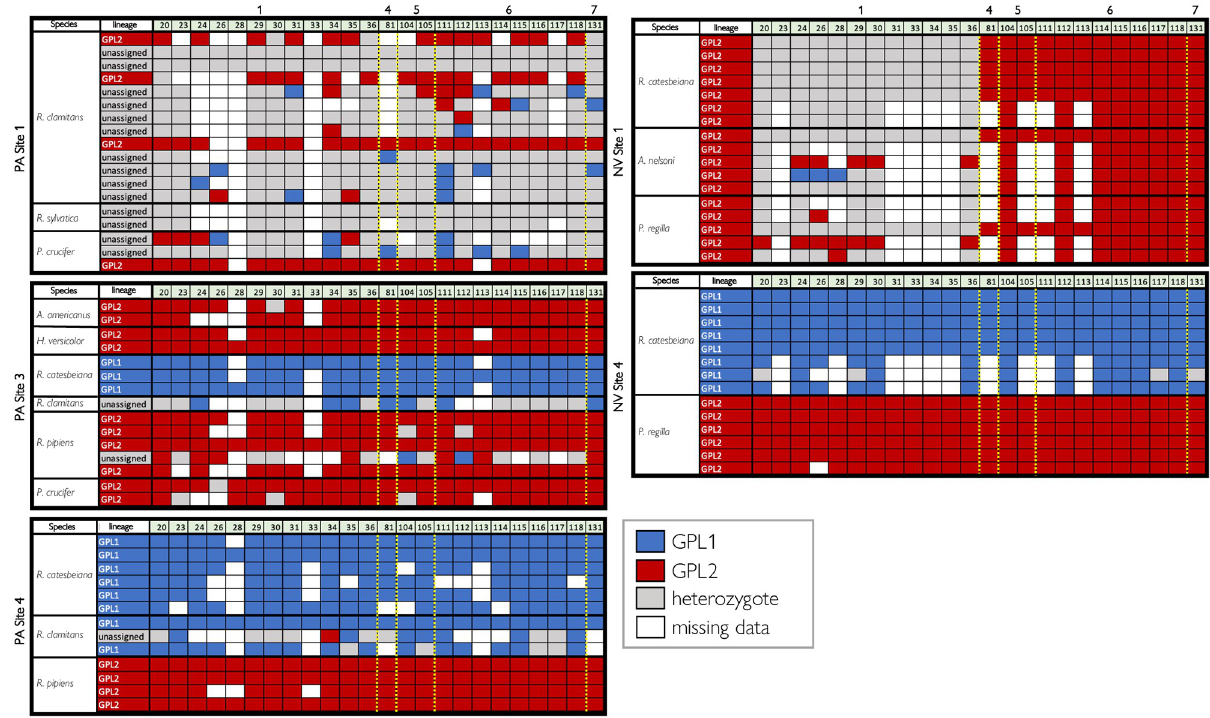
Fig 4. Alleles for PA Site 1 (left top), PA Site 3 (left middle), PA Site 4 (left bottom), NV Site 1 (right top), and NV Site 4 (right bottom). Each row represents an individual sample, and each numbered column represents a nuclear locus that has an informative GPL1/GPL2 allele (N = 24). Loci are organized according to position along the Bd genome, with the yellow dashed indicating a change to a new chromosome and the chromosome number labeled along the top. Samples are grouped by host species (“species” column) and labeled with the DAPC assigned lineage (“lineage” column). A red box indicates a Bd-GPL2 allele for that sample at that locus, a blue box represented a Bd-GPL1 allele, a gray box indicates both alleles are present, and a white box indicates missing data. Representative sequences for each allele are included in the supplemental materials.